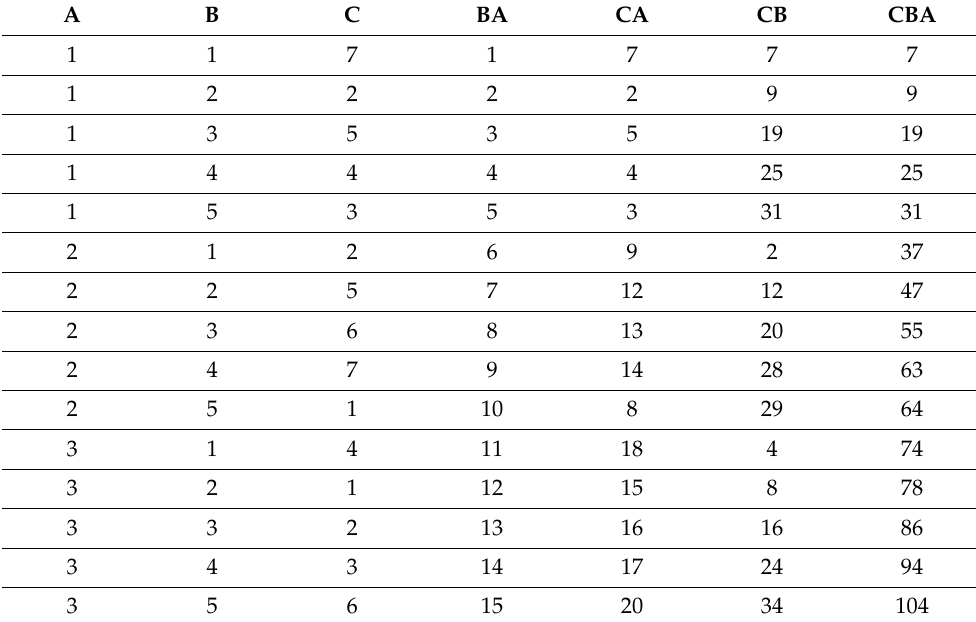
Table 1. Model matrix for EA (15, 3 1 5 1 7 1 ).